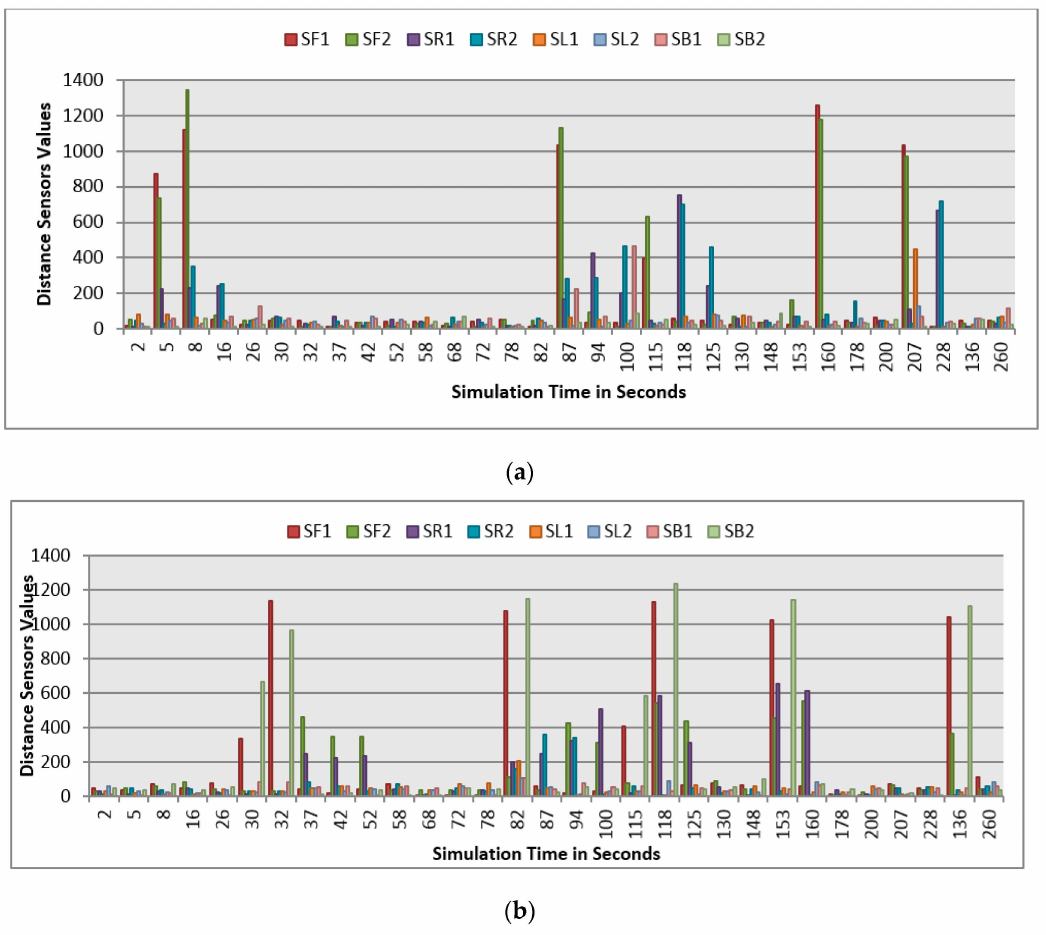
Figure 12. Distance sensor values for both robots at different simulation times. ( a ) Distance sensors readings at different simulation times for Robot 1; ( b ) Distance sensor readings at different simulation times for Robot